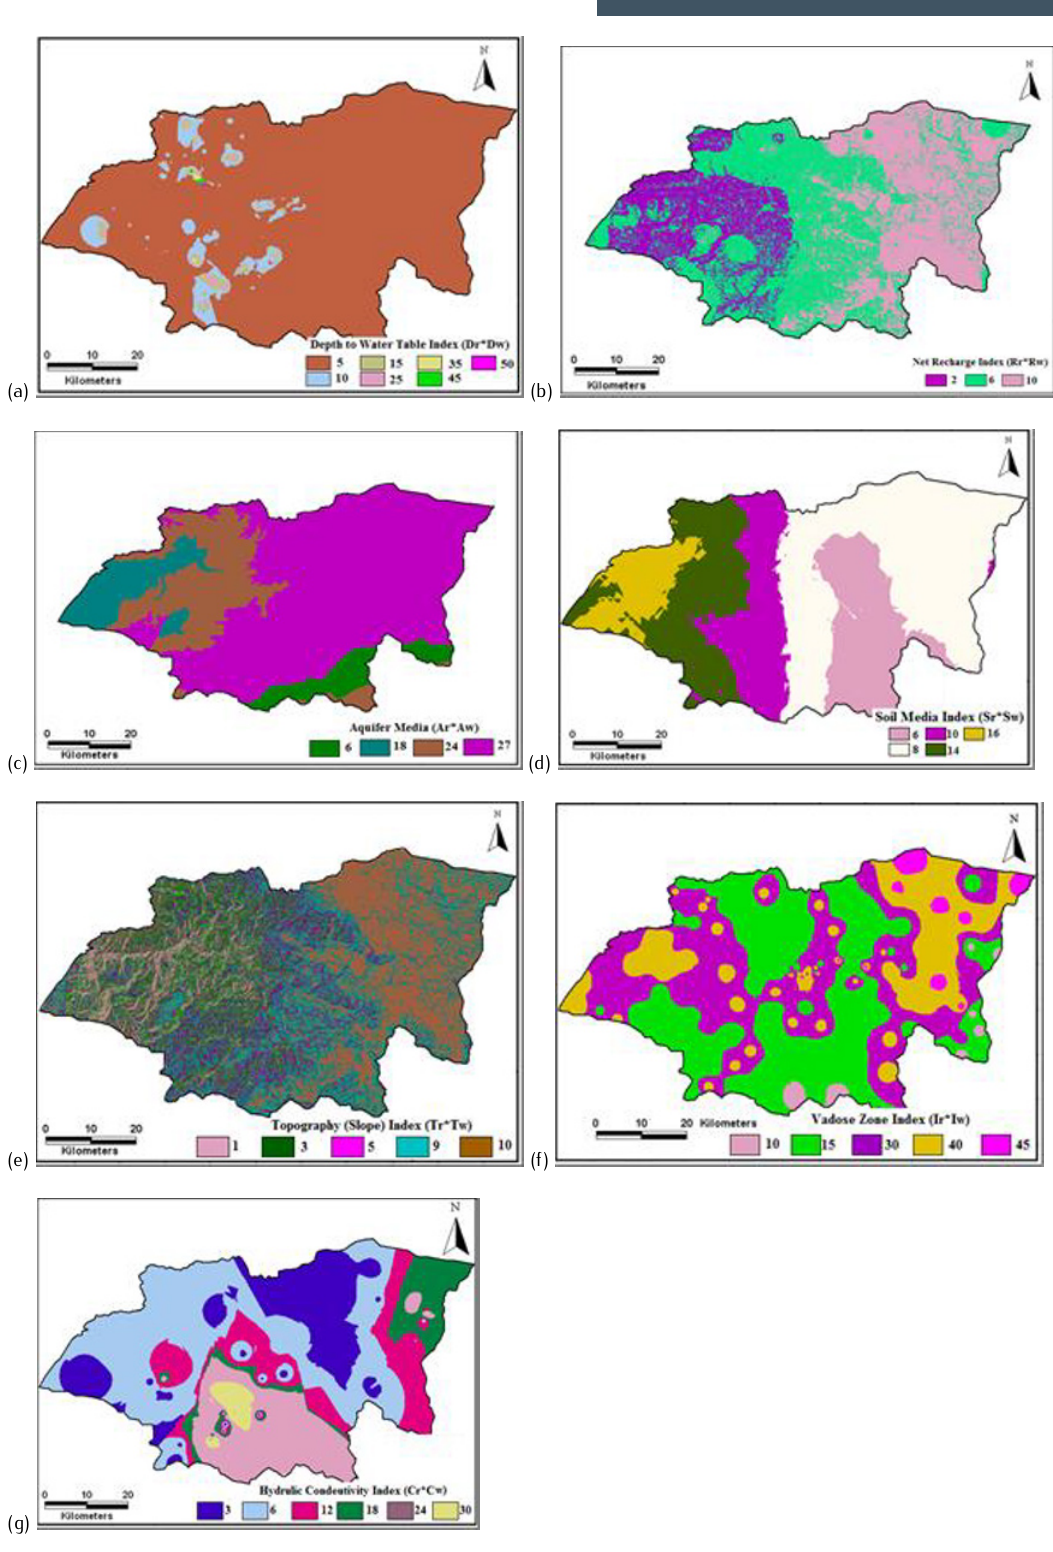
Figure 5. (a) Map index of depth-to groundwater table, (b) The spatial distribution for the ratings of the net recharge parameter, (c) Surface distribution of the hydrological units, (d) the spatial distribution for the index of the soil media parameter, (e) the spatial distribution for the ratings of the slope parameter, (f) the spatial distribution for the ratings of the unsaturated zone parameter, (g) Map index of hydraulic conductivity.